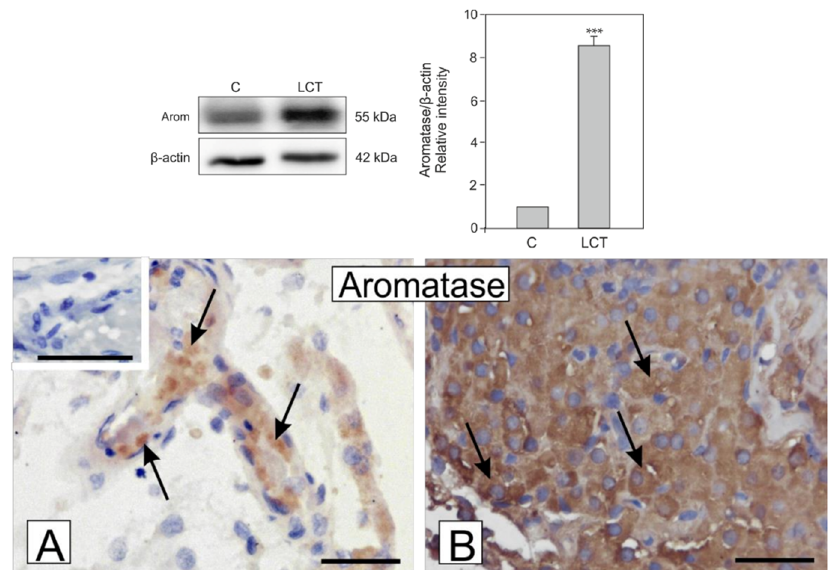
Figure 3. Expression (upper panel; blots and graph) and localization (lower panel; microphotographs) of aromatase in Leydig cell tumors. Representative blots and relative expression (arbitrary units) of qualitative expression of aromatase protein in Leydig cell of control testis (C) and a Leydig cell tumor (LCT). The relative amount of respective proteins normalized to β -actin. Relative intensity of bands from three separate analyses is expressed as means. Asterisks show significant differences between expression of control and treated Leydig cells. Data is expressed as means. Values are denoted as *** p < 0.001. Microphotographic documentation of DAB immunohistochemical localization of aromatase in Leydig cell of control testis (C) ( A ) and Leydig cell tumor (LCT) ( B ). Counterstaining with hematoxylin. Bar 20 µ m. Insert at A—negative control. Immunostaining was performed at least three times. Arrows depict positive staining.